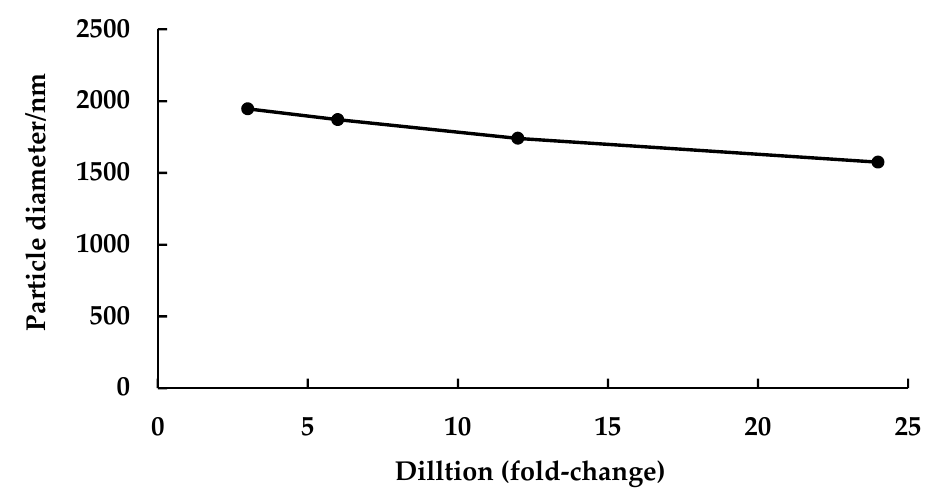
Figure 4. Dilution stability test: size change of CKR12-PLGA-MCZ micelles upon dilution in PBS (pH 7.4).